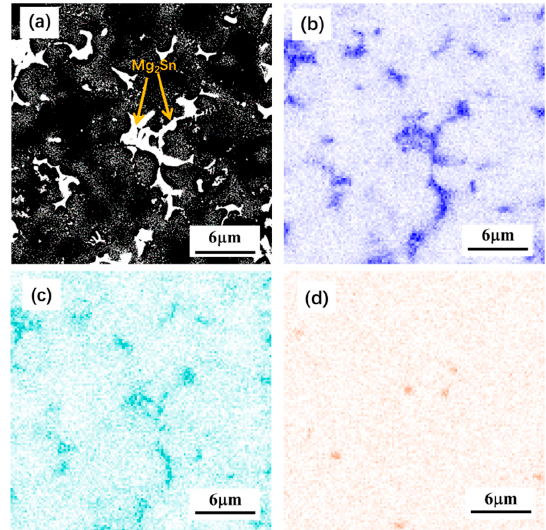
Figure 8. Back-scattered electronic image ( a ) and EDS element distribution of: ( b ) Zn, ( c ) Al, and ( d ) Sn in the as-cast ZAT642 alloy.